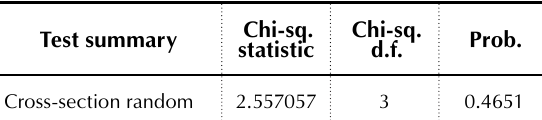
Table 3. Hausman test